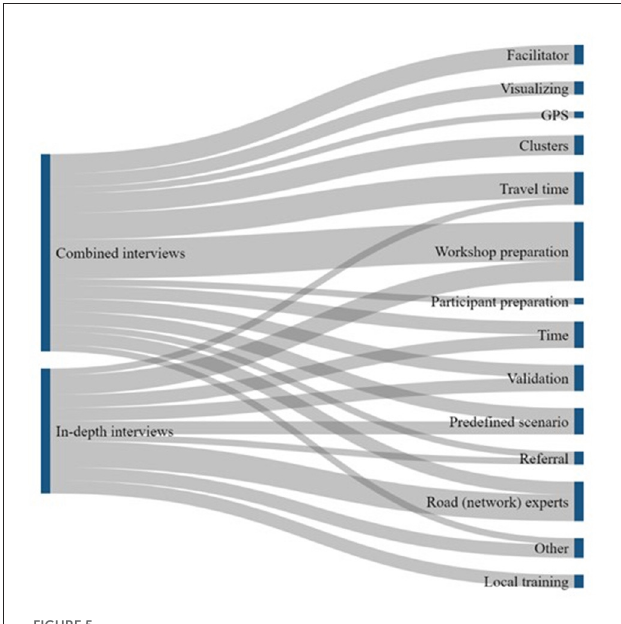
FIGURE5 Sankey diagrams showing which opportunities were most frequently emphasized by the interview